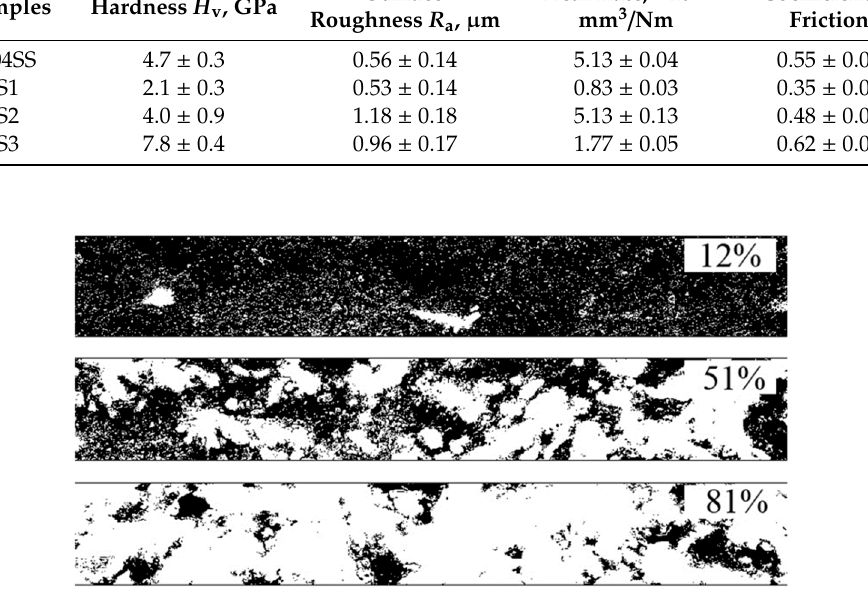
Figure 4. Binary images of suspension HVOF TiO 2 coatings converted from their greyscale images by image thresholding in order to assess the melting percentages: S1 (12%), S2 (51%) and S3 (81%).